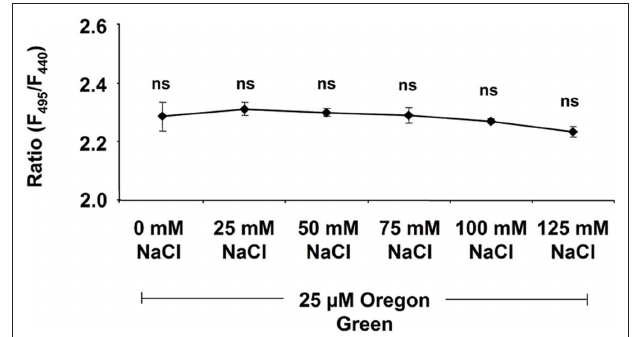
/F ratio on NaCl. 495 440